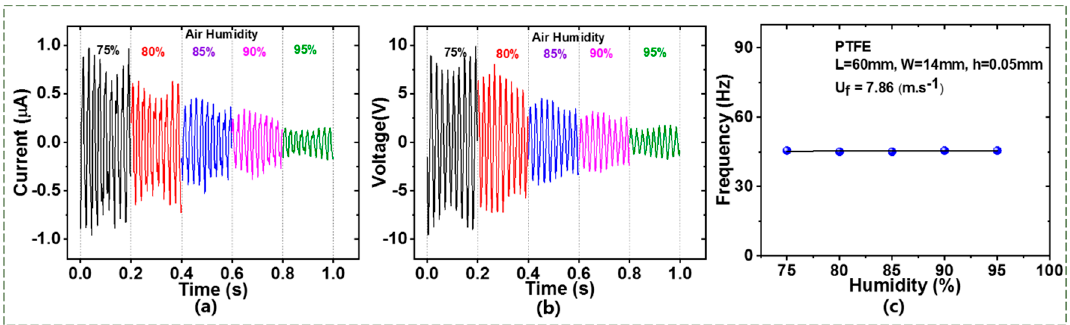
Figure 5. Humidity effect on the ( a ) current, ( b ) voltage, and ( c ) flutter frequency of the TENG